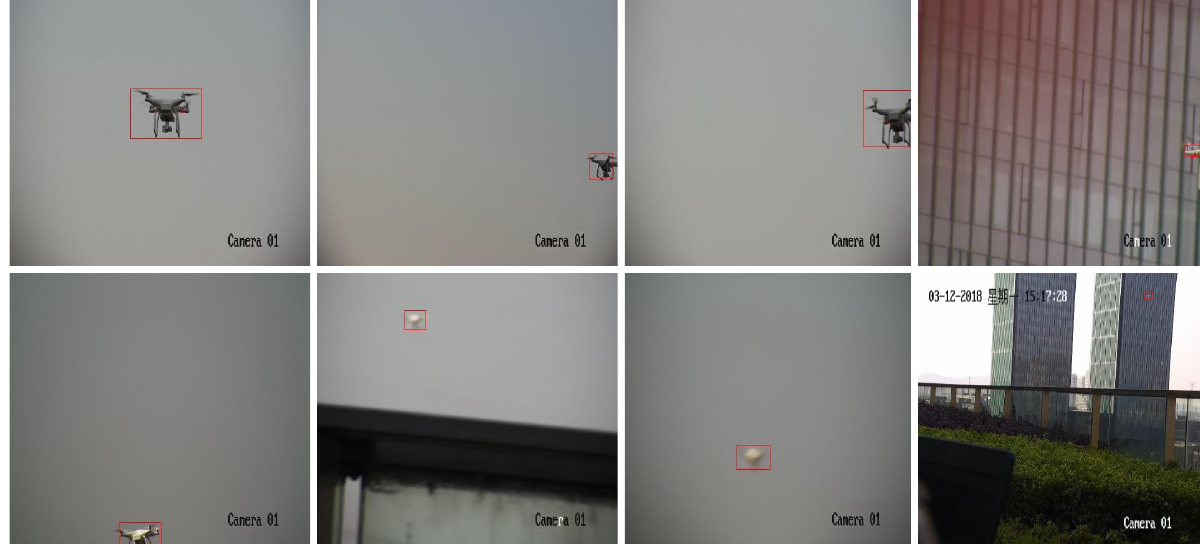
Figure 13. Illustration of the proposed system in different challenging scenarios (i.e., occlusion, complex background, camera motion, and so